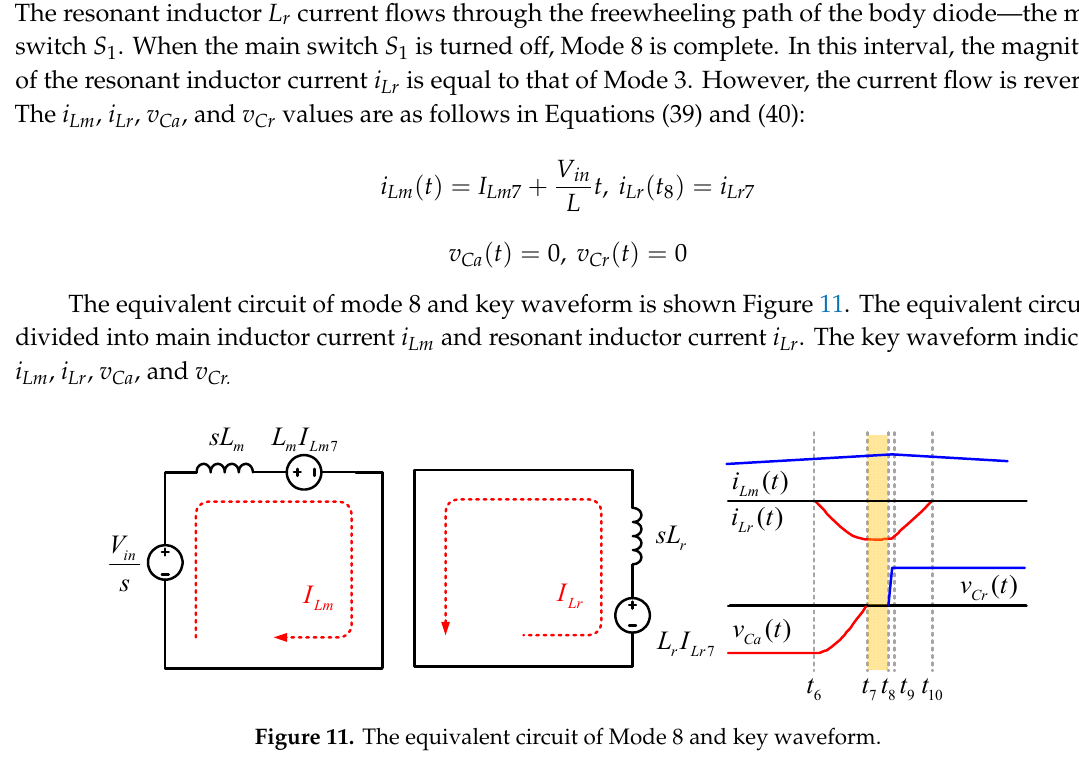
Figure 12. The equivalent circuit of Mode 9 and key waveform.